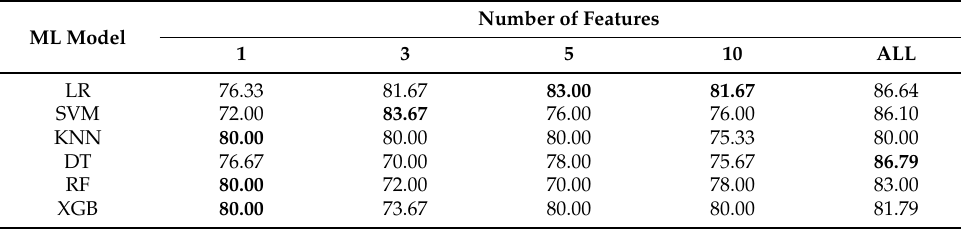
Table 9. HOA vs. HC accuracy of feature